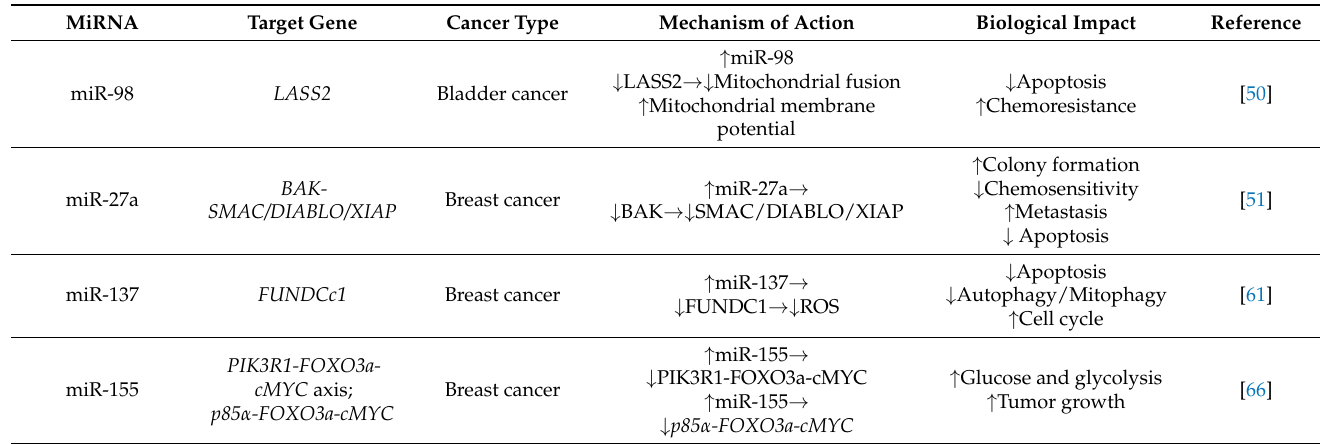
Table 1. MiRNAs identified with oncogenic function, their target genes, mechanism of action, and corresponding impact on distinct cancer cells phenotypes (presented by type of